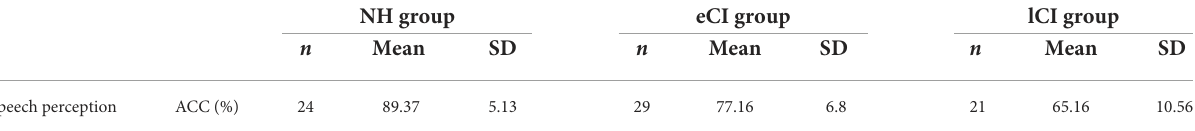
TABLE 3 The results of speech perception